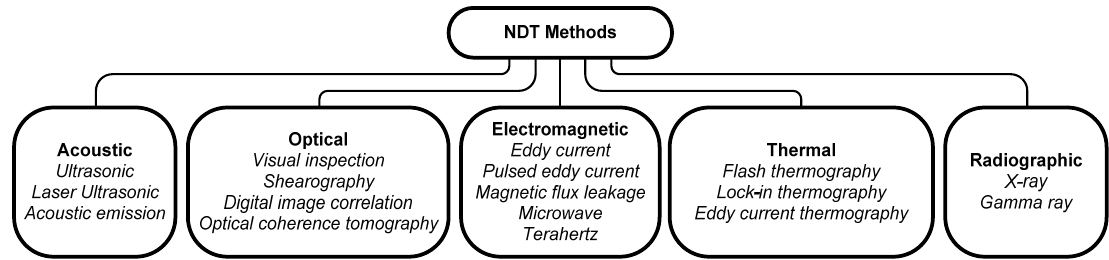
Figure 1. Categories of nondestructive testing (NDT) and evaluation of techniques [5].